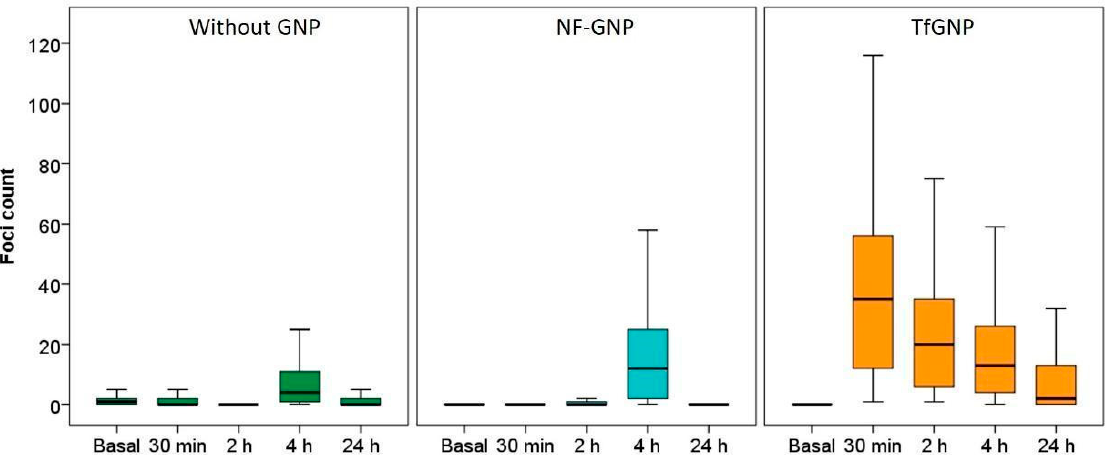
Figure 9. Box plots of the number of foci per cell in SKBR3 cells before (basal) and at different times (30 min, 2, 4 and 24 h) after irradiation, in the absence of GNPs (Without GNP) or in the presence of non-functionalized GNPs (NF-GNP) or transferrin-functionalized GNPs (TfGNP). Horizontal lines inside boxes indicate the median. Table 1. Sensitization enhancement ratio (SER) for foci frequencies and viability. Caco2 and SKBR3 cells were irradiated at 3Gy in the presence of functionalized GNPs (AntiEpCamGNP and TfGNP, respectively) and results were compared with those after irradiation in the absence of GNPs (w/o GNP) or in the presence of non-functionalized GNPs (NF-GNP). AntiEpCamGNP vs.